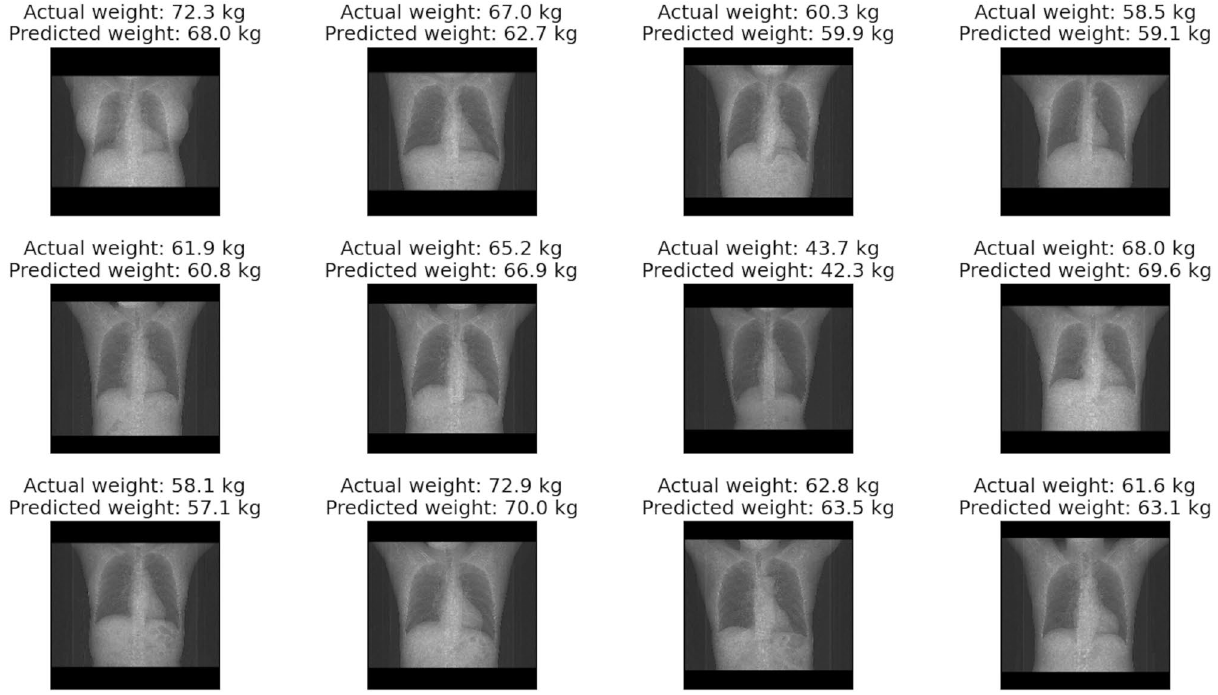
Figure 5. Representative cases of our CNN-based approach for predicting body weight in chest datasets. The upper row shows the actual body weight, and the lower row shows the predicted body weight from our CNN- based